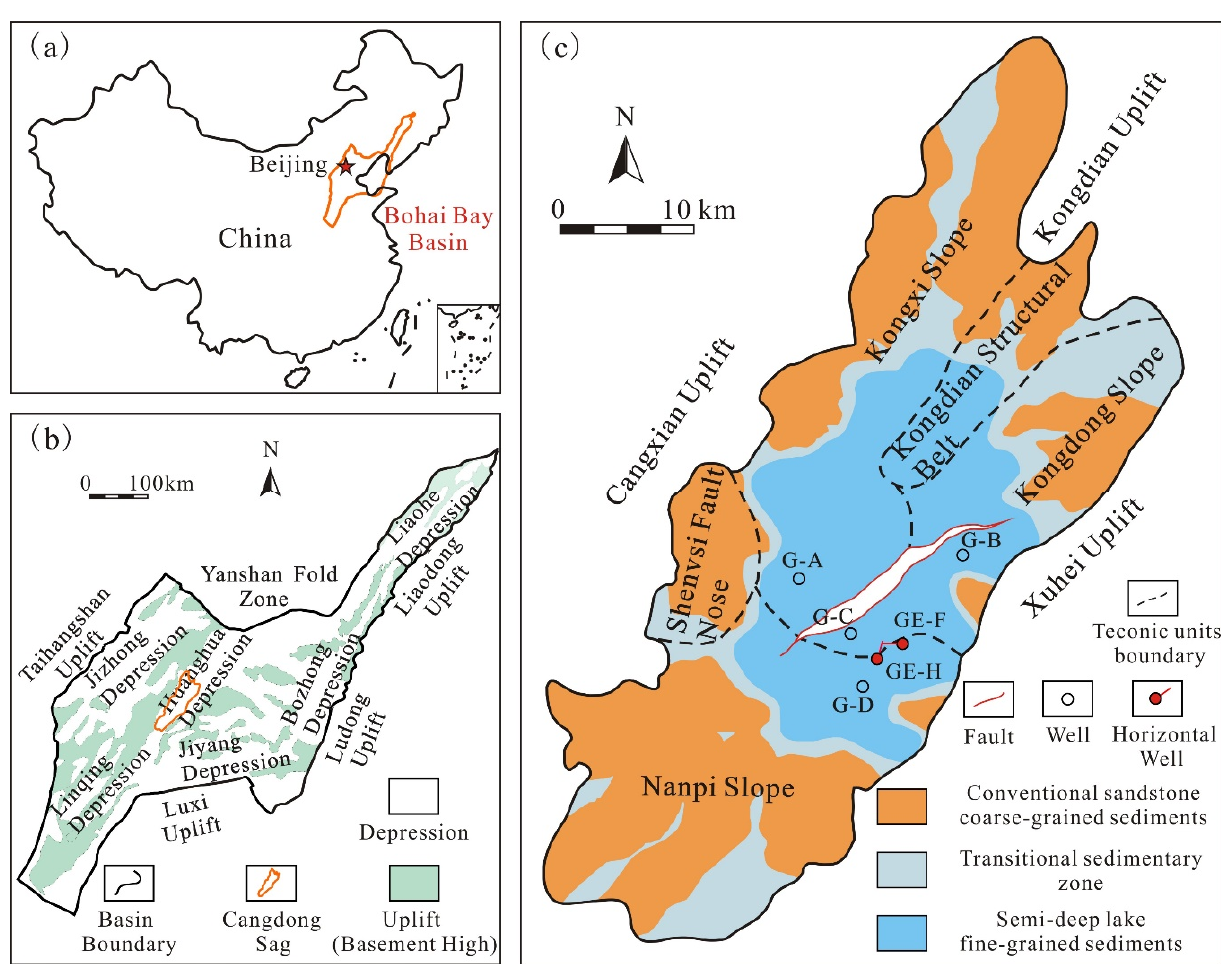
Figure 1. ( a ) Location of the Bohai Bay Basin in China (modified from [23]). ( b ) Structural map of the Bohai Bay Basin and location of the Cangdong Sag (modified from [23,24]). ( c ) Structural map with regional setting of the Cangdong Sag (modified from [18–25]).